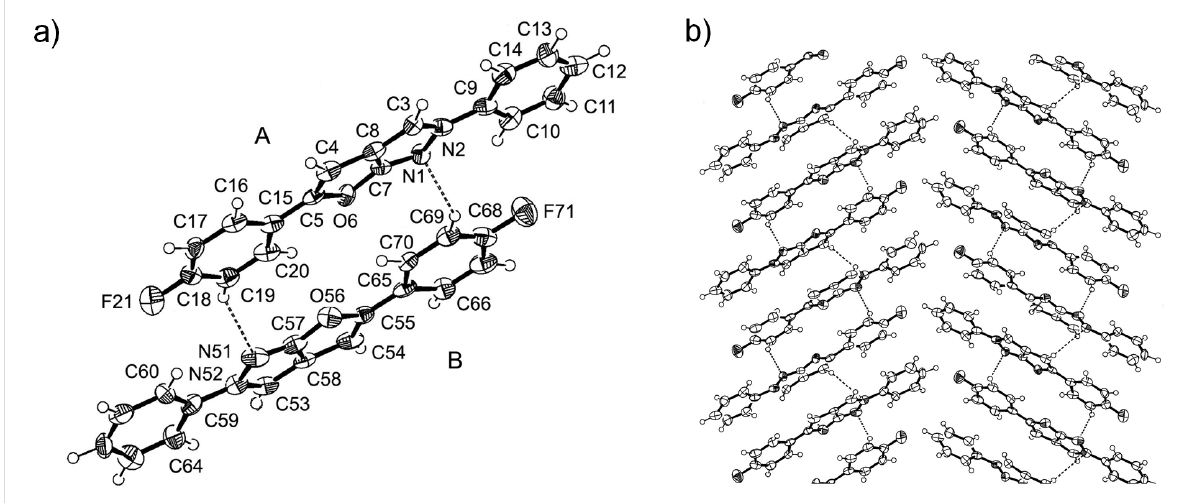
Figure 1: a) ORTEP diagram of the asymmetric unit consisting of two independent molecules 4d ( A ) and 4d ( B ); b) view (normal to (100)) of molecu- lar packing in the crystal.